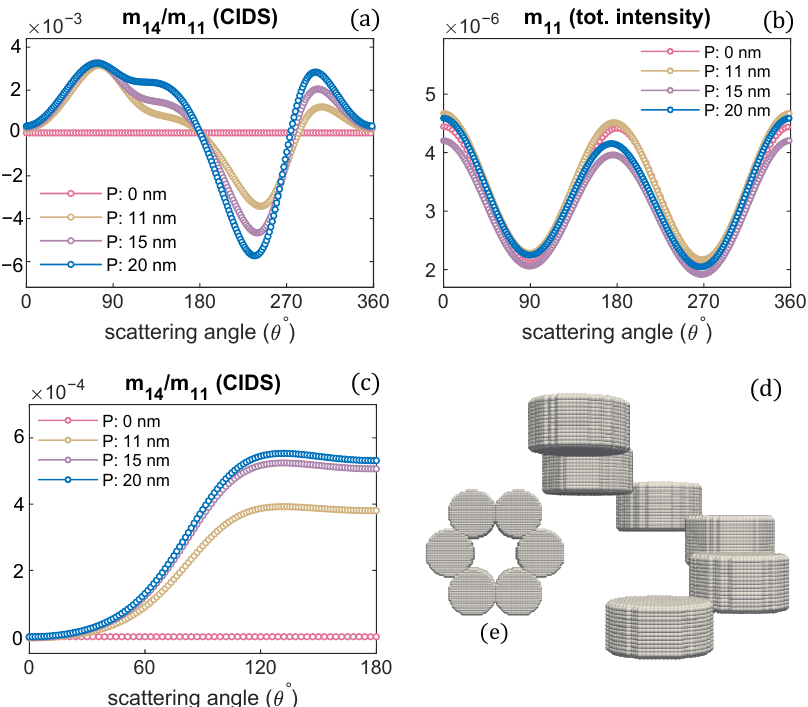
Figure 8. Varying pitch the scattering calculations are given: ( a , b ) at a fixed orientation ( α , β , γ ) = ( 0,0,0 ) , ( c ) and in the orientation average, ( d , e ) chromatin fiber and its projected view looking along the helix